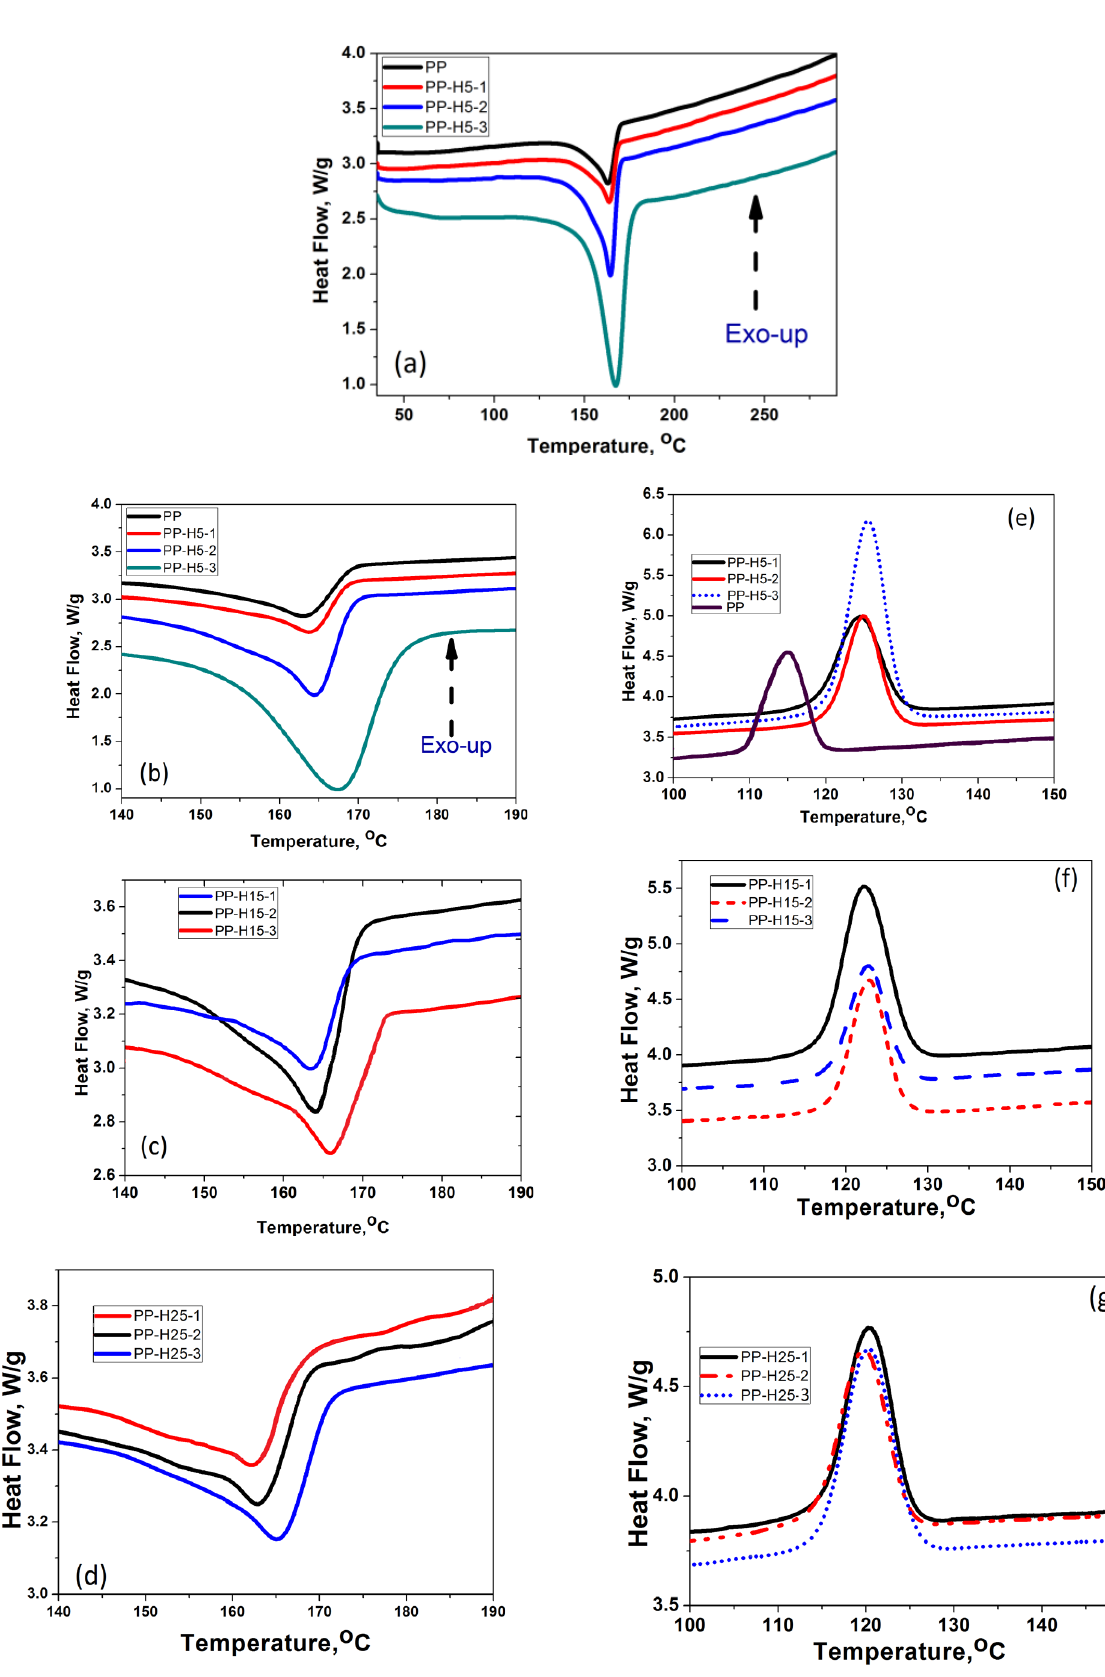
Figure 10. DSC thermograms of the prepared nanocomposites; ( a ) heating cycle at full experimental range, ( b – d ) heating cycles from 140 to 190 °C and ( e – g ) cooling cycles from 100 to 150 °C. The thermal stability of the nanocomposites was studied with TGA, with the results reported in Table 4. The initial (onset) degradation temperature (T D ) and the temperature at residual weight (T R ) were evaluated from Figure 11. Significant improvements in T D and T R were seen. The PP began to degrade at ≈250 °C, and it was enhanced to ≈353 °C for the PP-H5-3 nanocomposite. All of the three different GNPs increased the degradation temperature. Graphene nanoparticles block the mass transfer and restrict the molecular diffusion of bulk polymer to the outer surface during heating [50–53]. Thus; most of the volatile gases formed through heating are confined inside the body of the polymer composite, and restricted to fly [54–57]. The previously mentioned feature is a strong in- dication that graphene behaves like a fire-retardant in the PP matrix and causes im- provements in thermal stability [58–61]. The T D value decreased for large-sized GNPs incorporated in our study. Hence, large-sized GNPs exhibit inferior thermal stability. Similar results were also observed for T R . The T R increased by ≈100 °C for PP-H5-3 com-